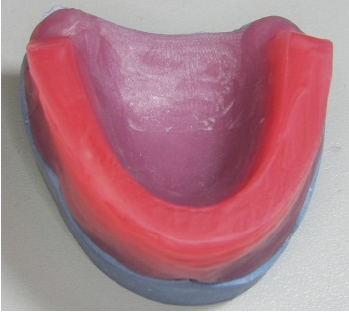
Figure 2. Baseplate-wax rim.